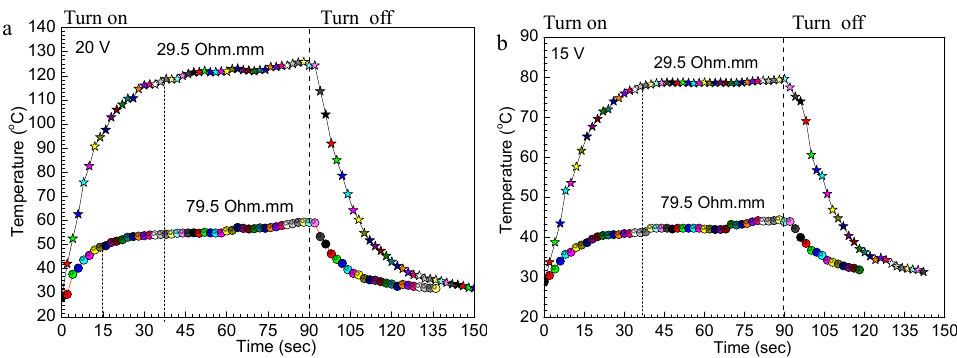
Figure 8. Temperature versus time for the RGO / NCC-TPU conductive films with resistivity of 29.5 and 79.5 Ω · mm, respectively, under the operation for input voltage 20 V ( a ) and 15 V ( b ), respectively.